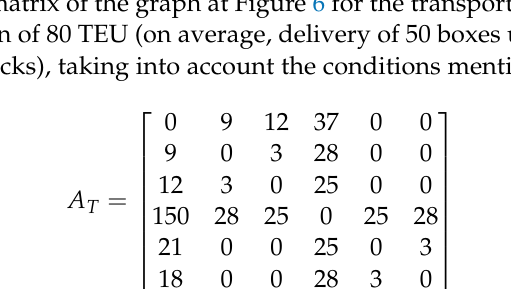
Figure 6. Transport modes and transhipment points adapted in the case study. Transhipment at the intermodal terminal or at the inland waterway barges loading and storage site by a mobile crane with 15 movements per hour and average engine power of about 500 kW should be considered when calculating the total transport time, costs and energy demand.